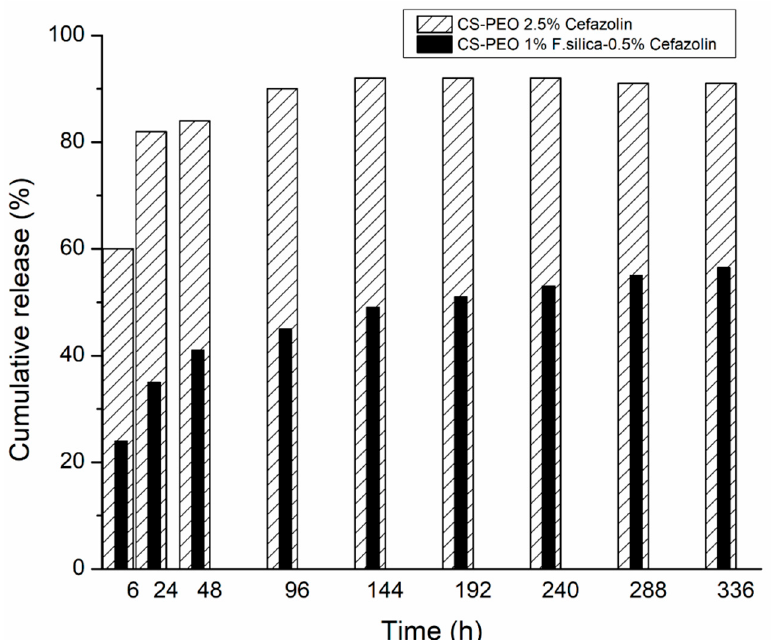
Figure 3. The release diagram for CS-PEO 2.5% Cefazolin and CS-PEO 1% F. silica-0.5% Cefazolin nanofibrous mats (adapted from [58]).